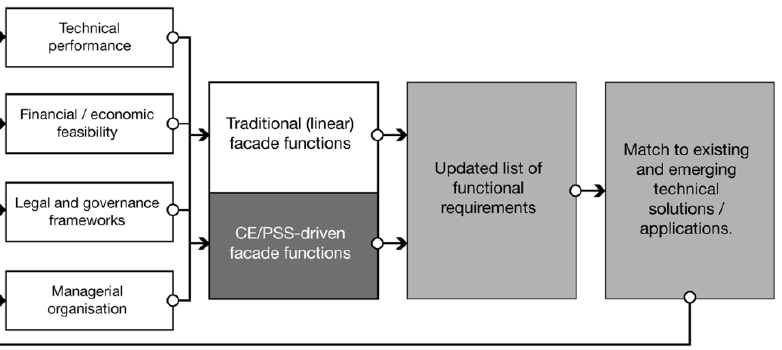
Figure 2. Research-through-design feedback loop in the multi-staleholder co-creation process of the two façade leasing (FaaS) prototypes.